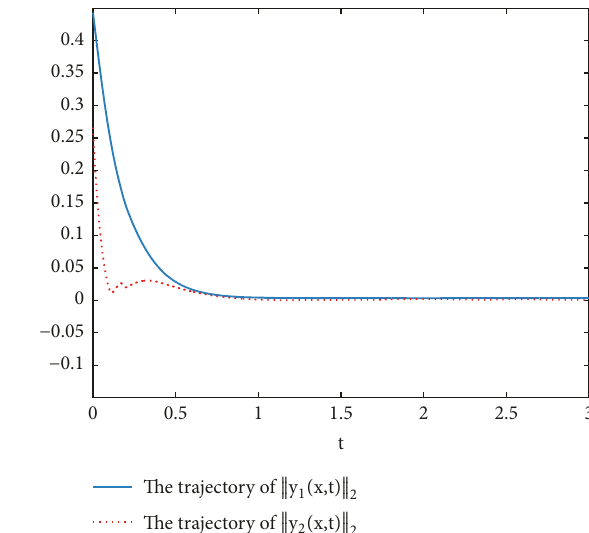
Figure 8: The closed-loop trajectories of ‖𝑦 1 (𝑥,𝑡)‖ 2 and ‖𝑦 2 (𝑥,𝑡)‖ 2 .